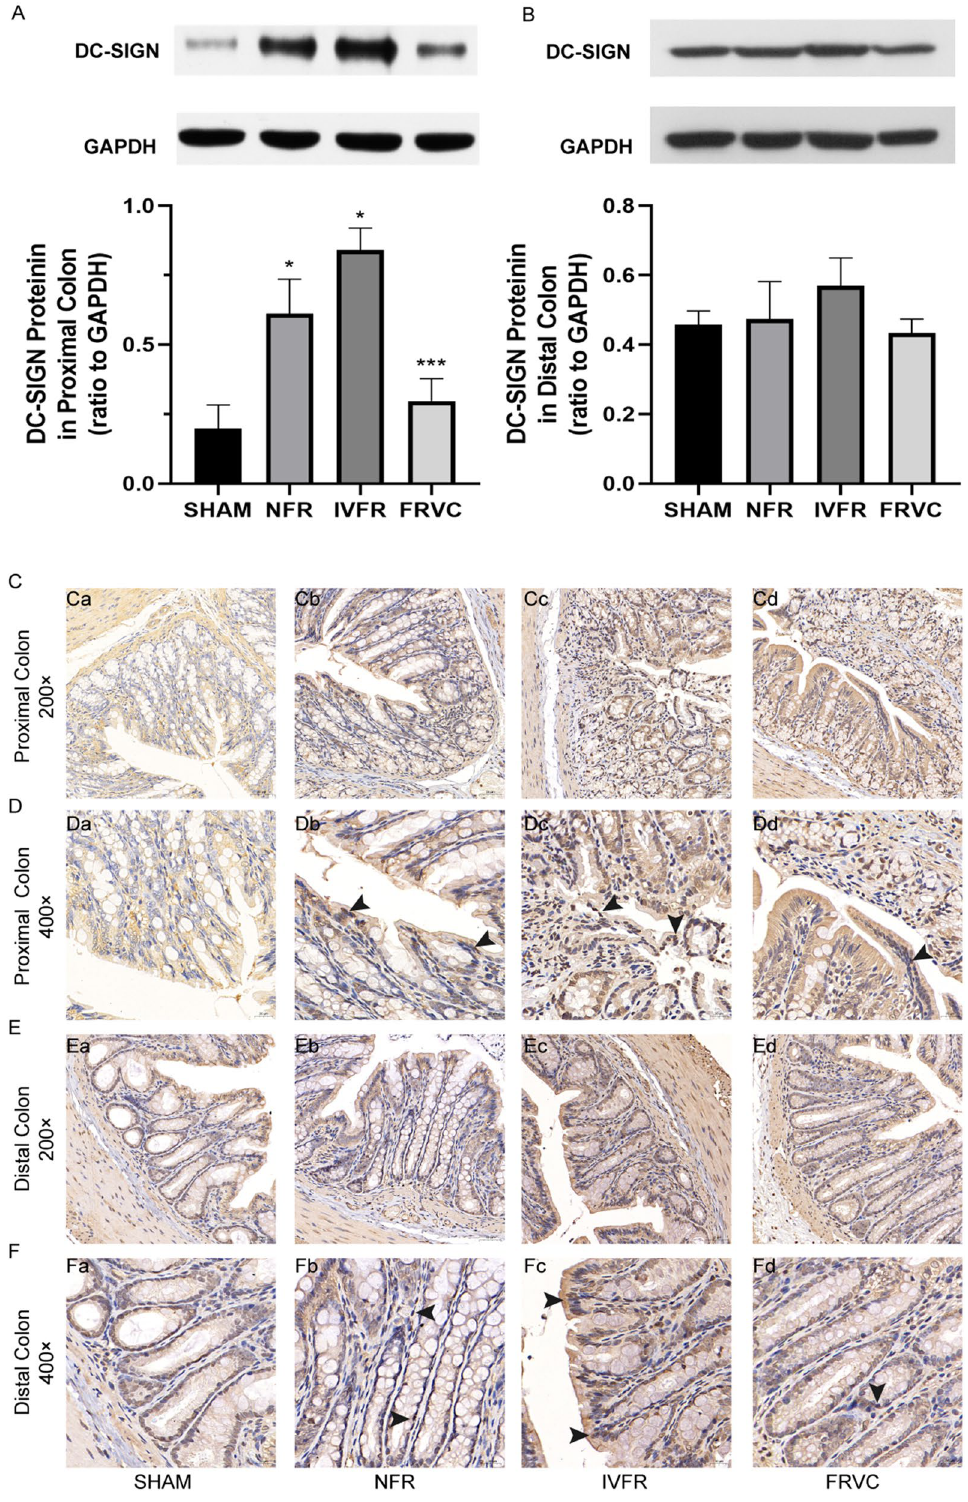
Figure 2. FRVC inhibits the expression of DC-SIGN in the proximal colon of SAP rats. ( A ) Western blot analysis of DC-SIGN expression in the proximal colon. ( B ) Western blot analysis of DC-SIGN expression in the distal colon. ( C , D ) Immunohistochemical staining of DC-SIGN expression in the proximal colon. ( E , F ) Immunohistochemical staining of DC-SIGN expression in the distal colon. * p < 0.05 compared to SHAM, ** p < 0.05 compared to NFR; *** p < 0.05 compared to IVFR. SHAM: the rats treated with sham operation and no fluid resuscitation; NFR: the rats treated with the SAP operation and no fluid resuscitation; IVFR: the rats treated with the SAP operation and intravenous normal saline infusion; FRVC: the rats treated with the SAP operation and normal saline infusion via